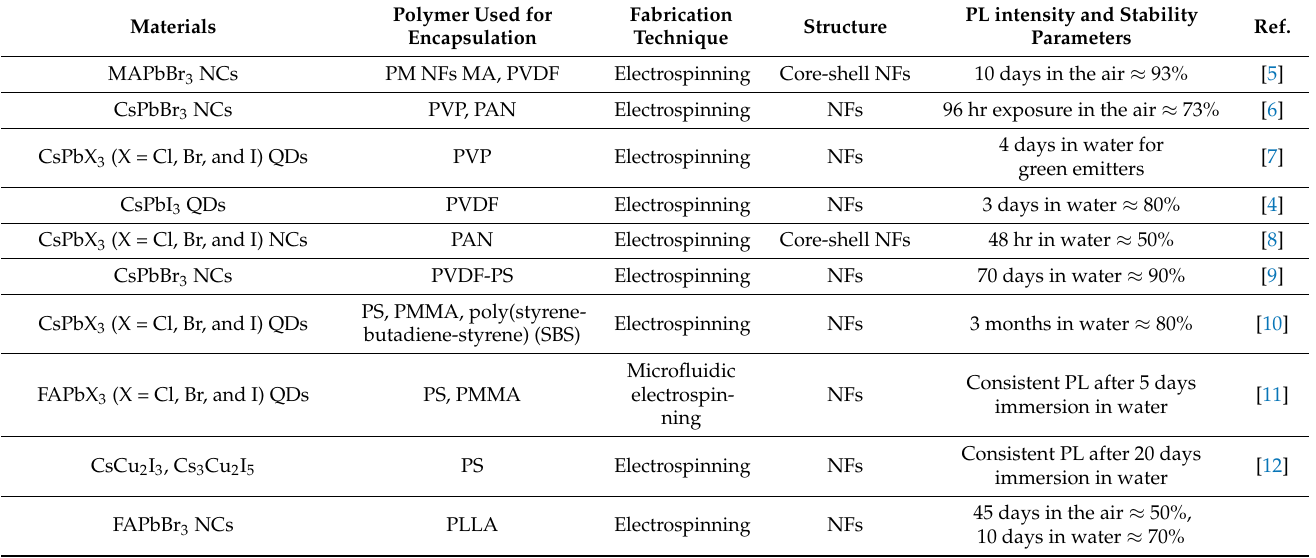
Table 1. Comparison of the FAPbBr 3 perovskite NCs incorporated in poly (L–lactic acid) nanofibers with some other